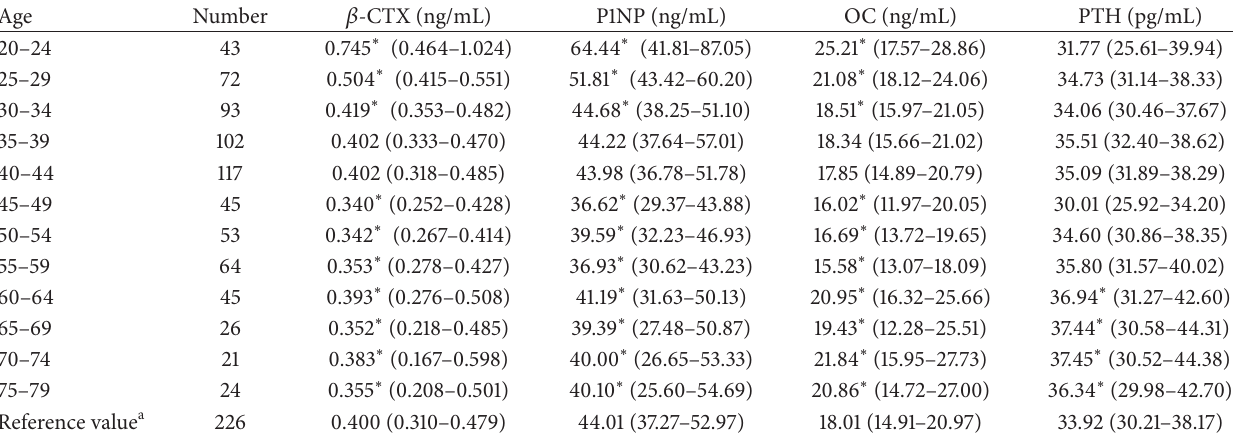
Table 4: Geometric means and (95% CI) for the age-specific measurements of bone turnover markers in healthy men.